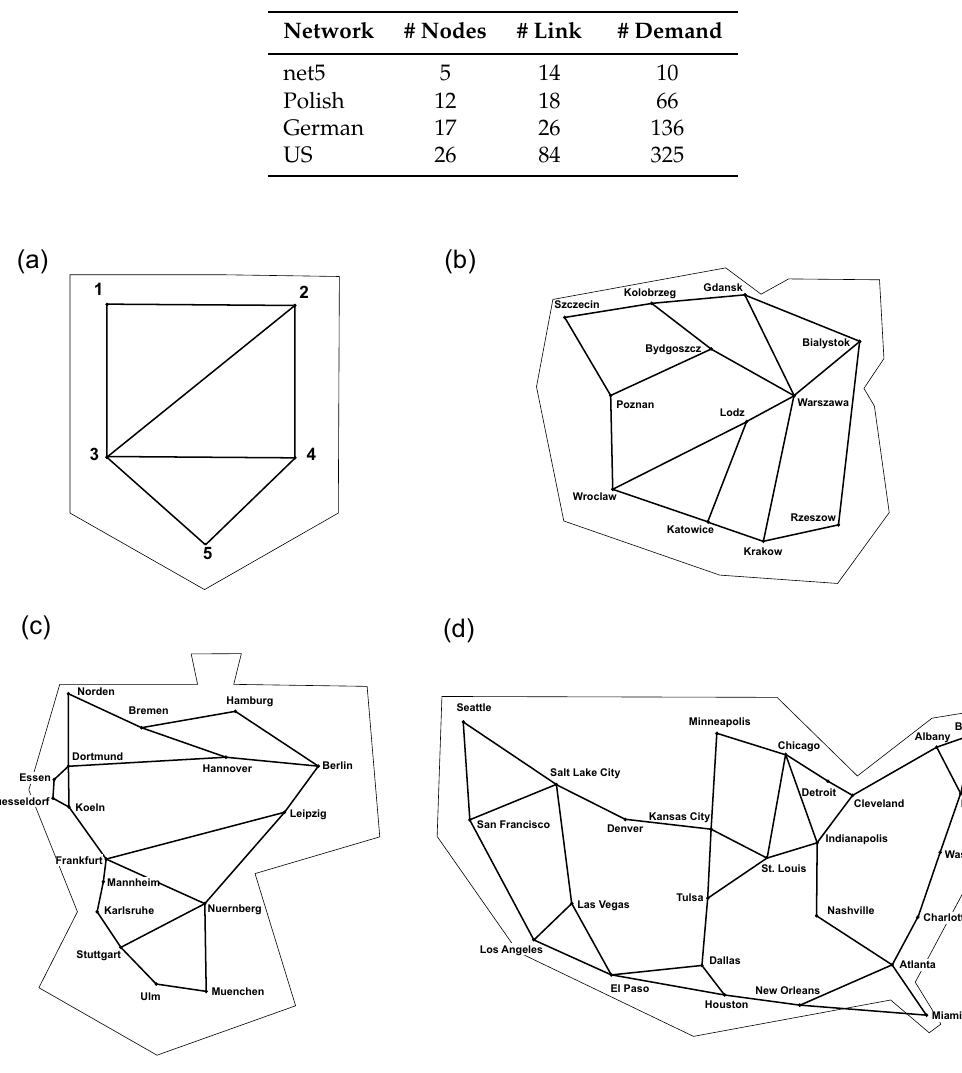
Figure 3. Analyzed network topologies: ( a ) artificial 5-node network; and ( b ) Polish, ( c ) German, ( d ) American (US) national transmission optical backbone